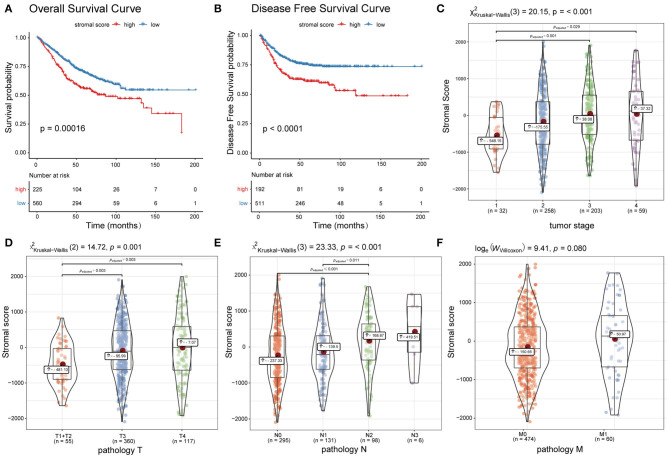
Association between the ESTIMATE stromal score and CC survival prognosis and clinical features. (A) Overall survival curves and (B) disease free survival curves of the high and low stromal score groups. (C–F) Boxplots of the ESTIMATE stromal scores of different groups with regards to T, N, and M pathology results and tumor stage.